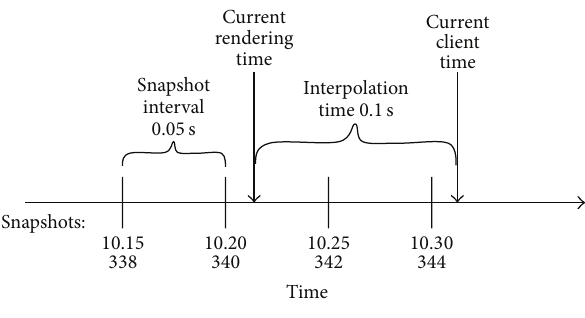
Figure 2: Object interpolation [17,